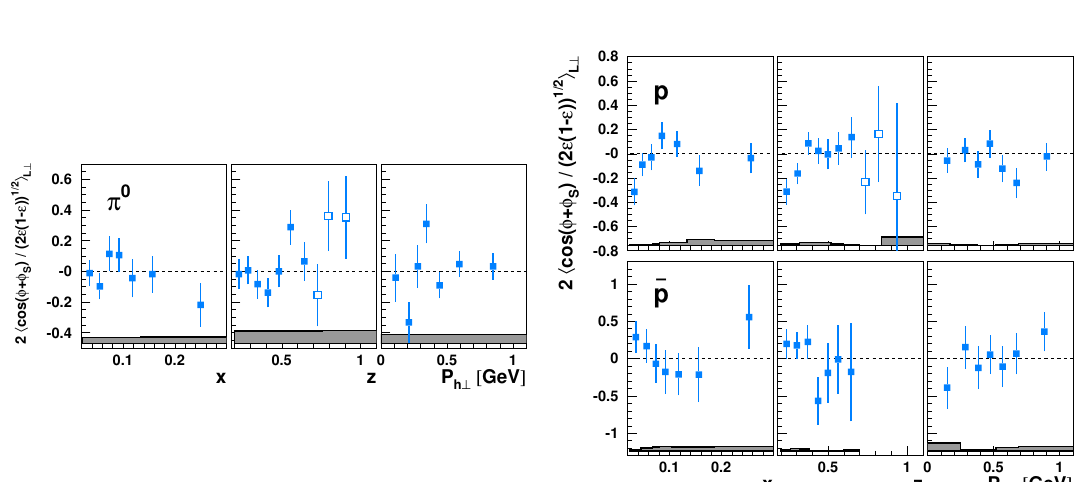
p Figure 36 . The 2 h cos( φ + φ S ) / 2 (cid:15) (1 − (cid:15) ) i h amplitudes for π 0 (left), protons, and antiprotons L ⊥ (right) presented either in bins of x , z , or P h ⊥ . Data at large values of z , marked by open points in the z projection, are not included in the other projections (no such high- z points are available for an- tiprotons due to a lack of precision). Systematic uncertainties are given as bands, not including the additional scale uncertainty of 8.0% due to the precision of the target-polarization